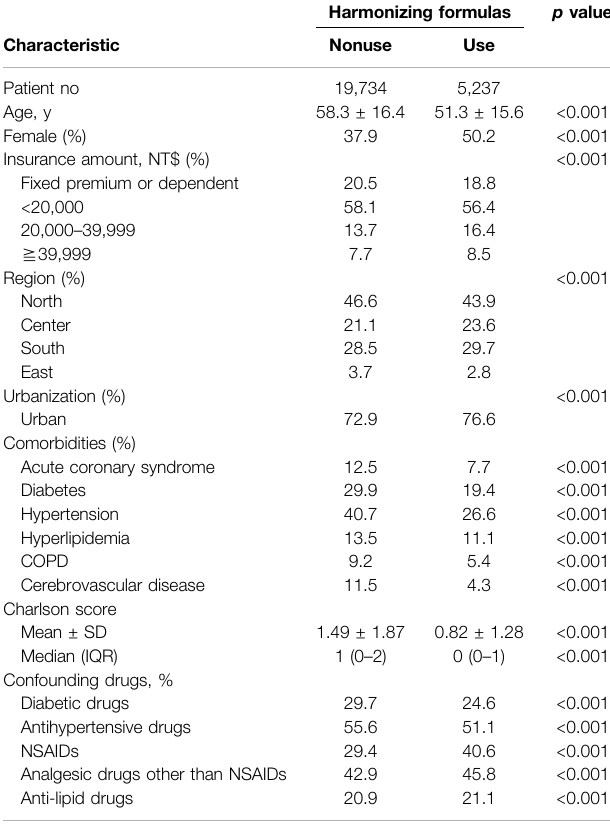
TABLE 1 | Characteristics of study cohort by harmonizing formula